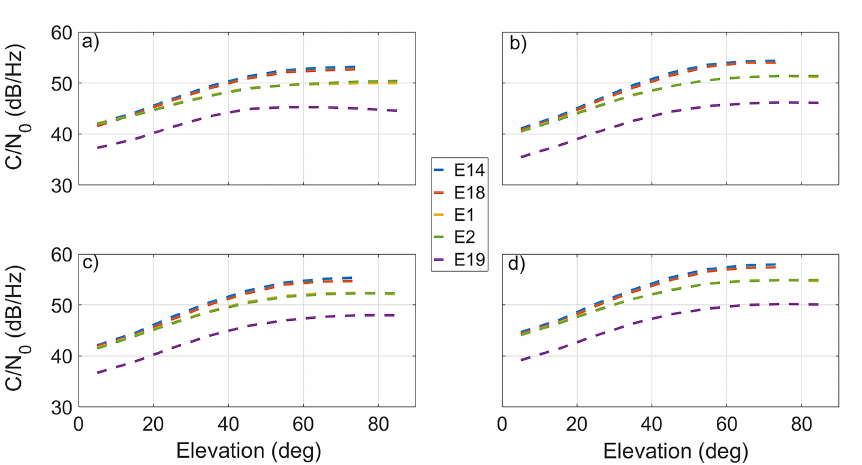
Figure 3. Carrier-to-Noise density ratio (C/N 0 ) of the Milena (E14), Doresa (E18), E1, E2, and E19 (IOV) Galileo satellites (depicted in blue, red, yellow, green, and purple dotted lines, respectively) on different frequencies as a function of satellite elevation. The E1, E5a, E5b, and E5 frequencies are reported in ( a – d ), respectively. Each panel shows the average of C/N 0 over elevation bins of 10 degrees. Data plotted refer to DOYs 52–71 of